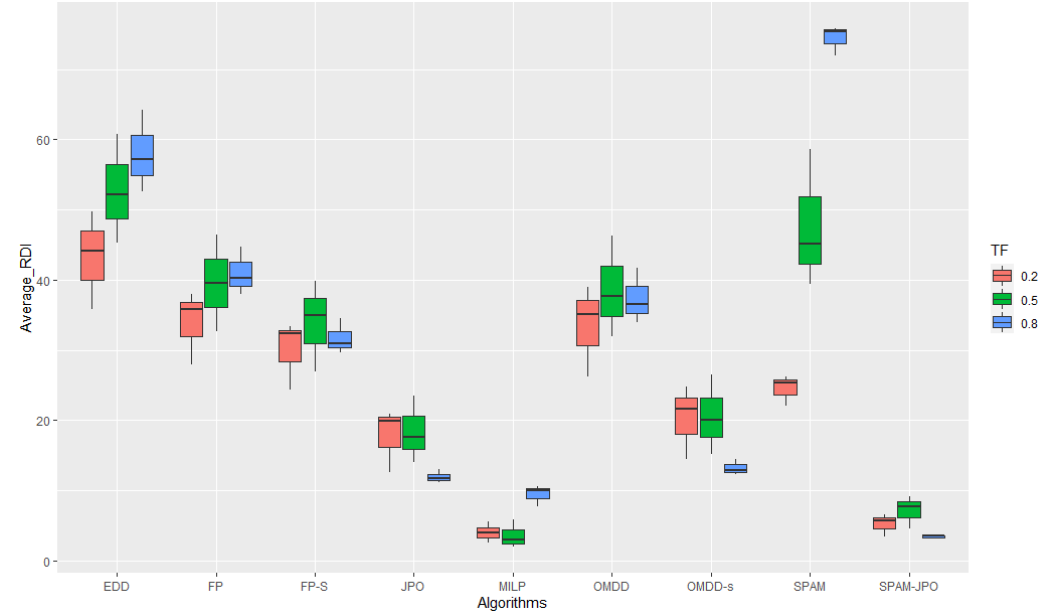
Fig. 7. Large-sized test instances: boxplot for average 𝑅𝐷𝐼 values depending on 𝑇𝐹